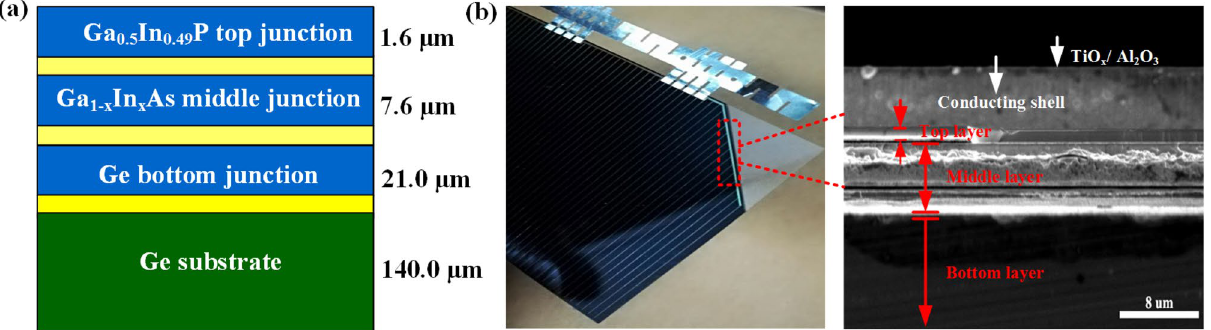
Figure 8. ( a ) Structure sketch of the PV cell used in experiments 35 . ( b ) Optical photo and cross-sectional SEM image of the triple-junction GaInP/GaInAs/Ge thin